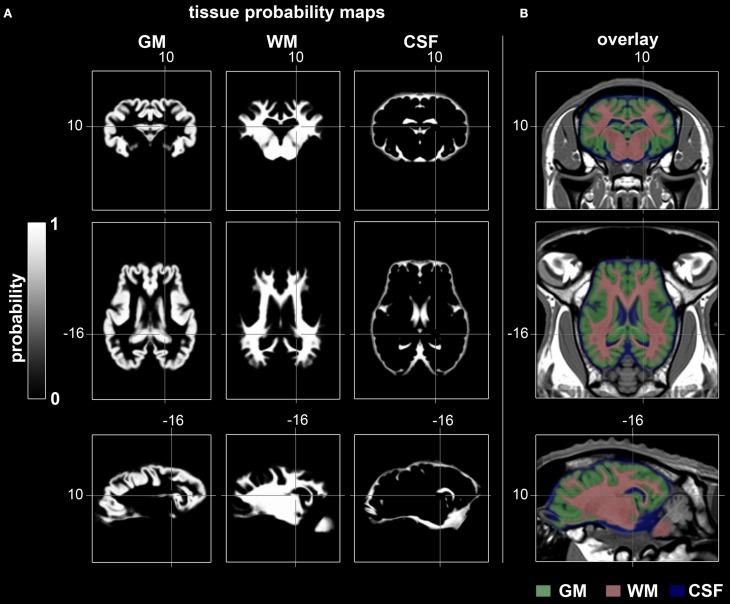
Coronal, transverse, and sagittal slices visualizing GM, WM, and CSF tissue probabilities. (A) TPM were created by averaging binary coded, segmented images from the 14 non-linearly registered subjects. Values range from 0 (black) to 1 (white). (B) Merged overlay of GM (green), WM (red), and CSF (blue) TPM with the template. Stereotaxic coordinates are given in mm. GM, gray matter; WM, white matter; CSF, cerebrospinal fluid.